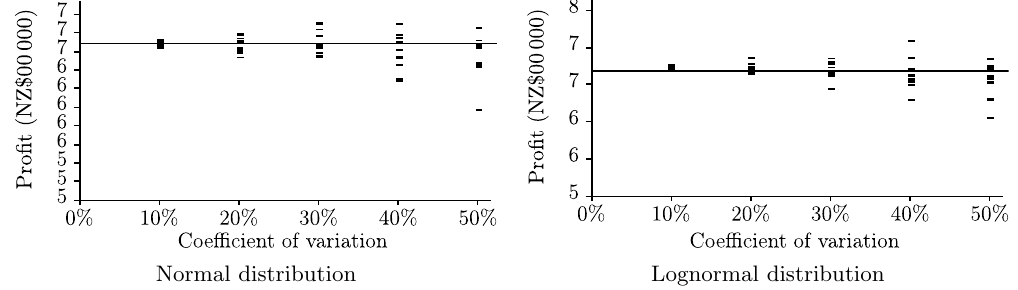
Figure 7: Fluctuation in the profit of a 10-period model of IFPM due to variability in catch rate with the mean decreased by 66.6%. The deterministic solutions are shown in dotted lines.